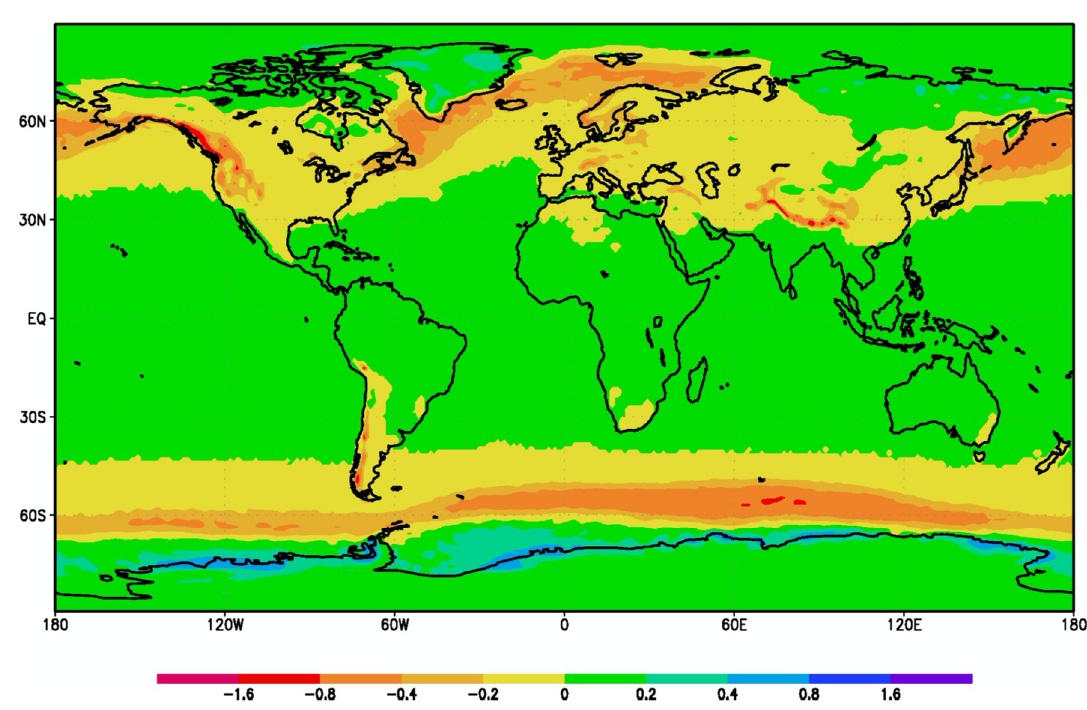
Figure 4. The change in annual solid precipitation expected in the last three decades of this century, computed with ECHAM5 T106 under the IPCC Scenario A2 (scale at the bottom is in mmd − 1 ). Note that he northwest of North America is forecast to lose 500–600 mma − 1 precipitation.